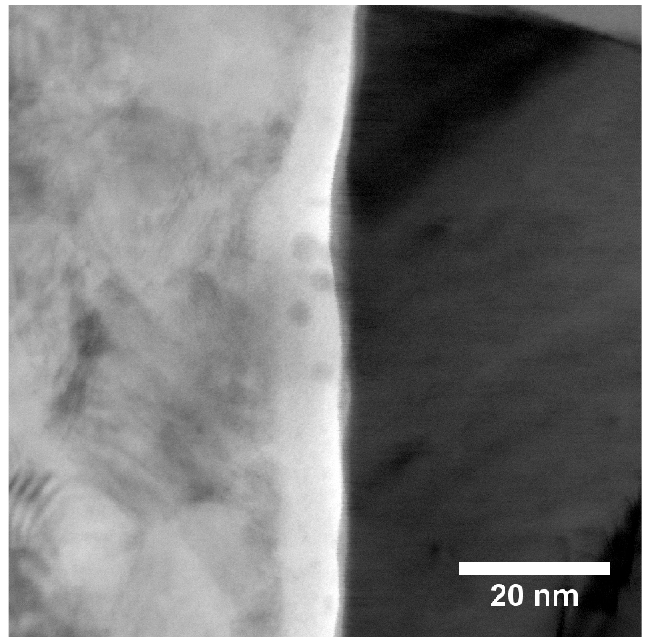
Figure 6. STEM BF image of sample “Au” indicating the presence of Au nanoparticles in the interfacial oxide layer between larger Au particles and the steel